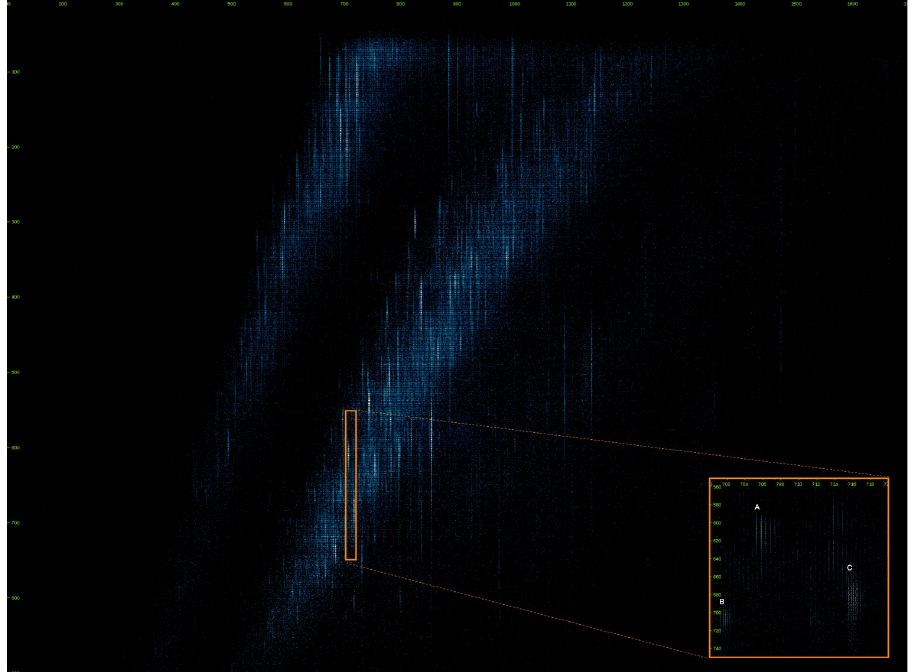
Fig 1. A raw data MS1 full-frame view at an instant of retention time. The inset shows an enlarged region of the frame with three candidate features visible; (A) a charge 2+ feature, (B) and (C) charge 4+ features.